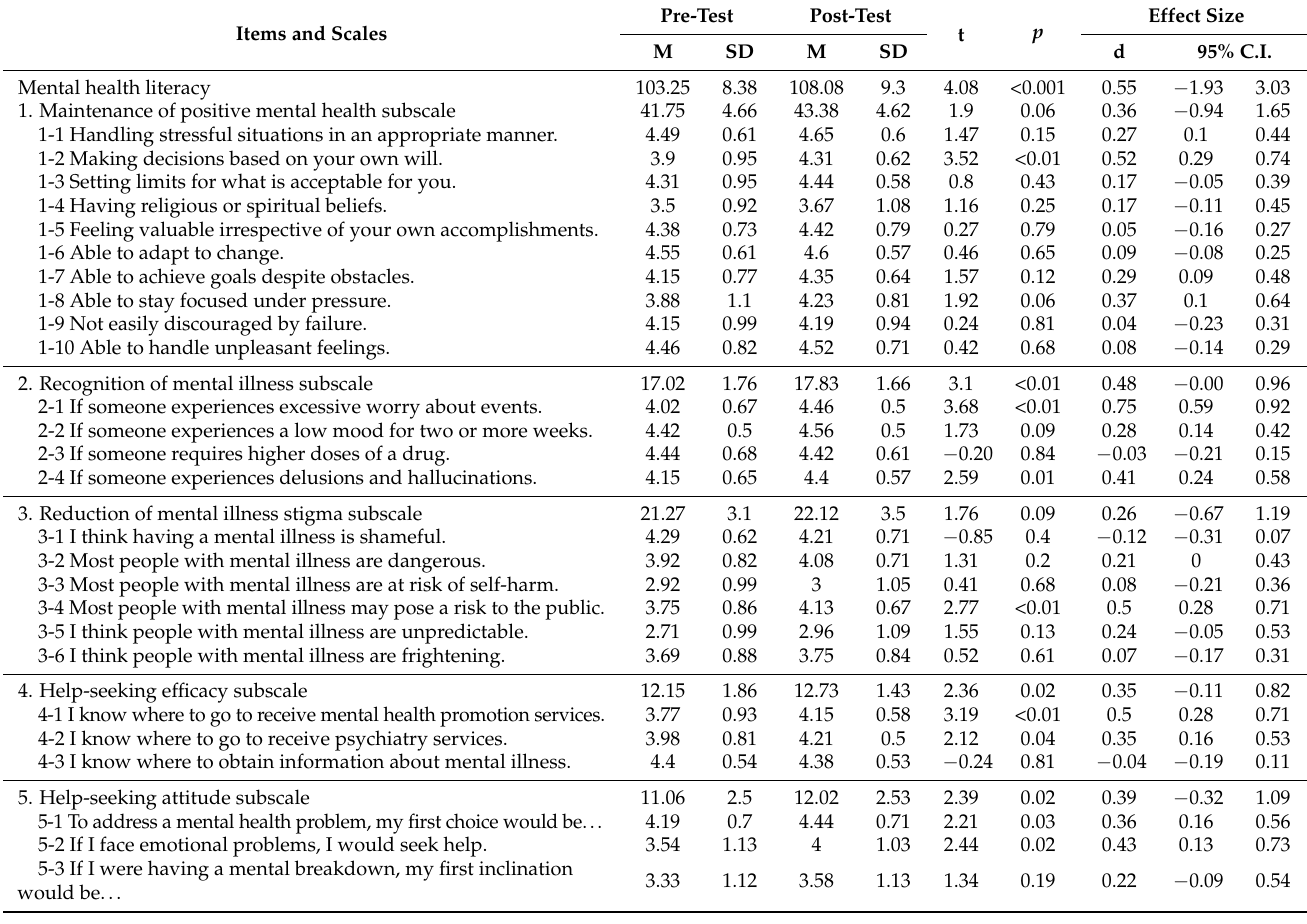
Table 3. Differences of mental health literacy, subscale and items scores between pre- and post-test surveys ( n = 48).